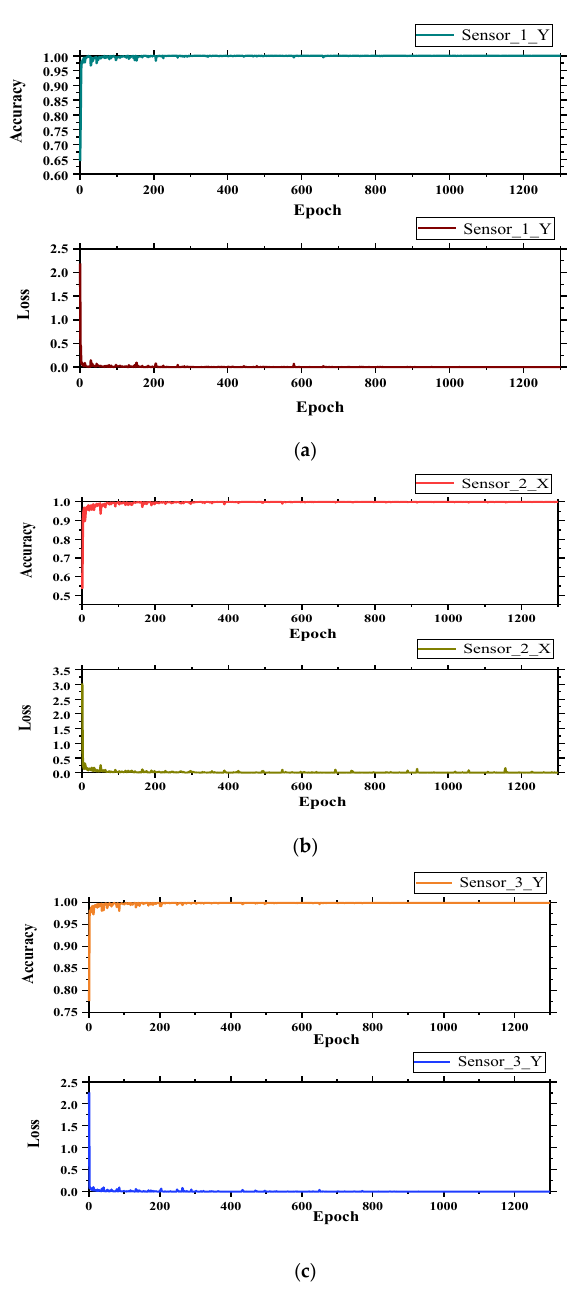
Figure 12. Single-channel VGG16 model evaluation metrics. ( a ) Y-channel of sensor 1 under l = 10, ξ = 35 ◦ ; ( b ) X-channel of sensor 2 under l = 6, ξ = 25 ◦ ; ( c ) Y-channel of sensor 3 under l = 6, ξ = 30 ◦ .